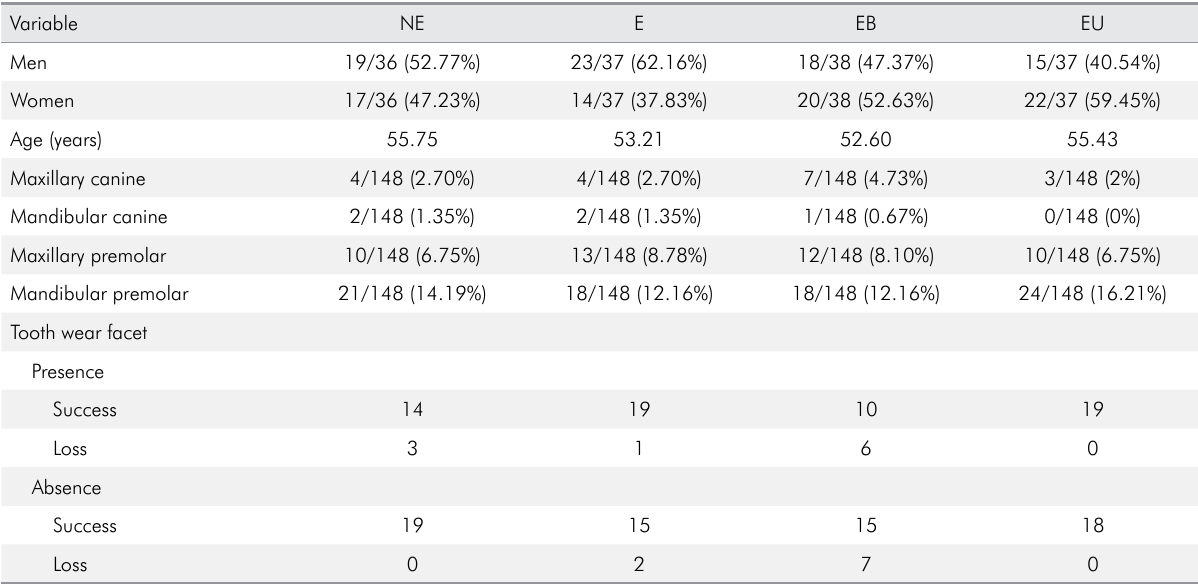
Table 1. Demographics of the studied population. Distribution into studied groups by sex, age, restored teeth, and the frequency of wear facets in relation to restoration success or failure.